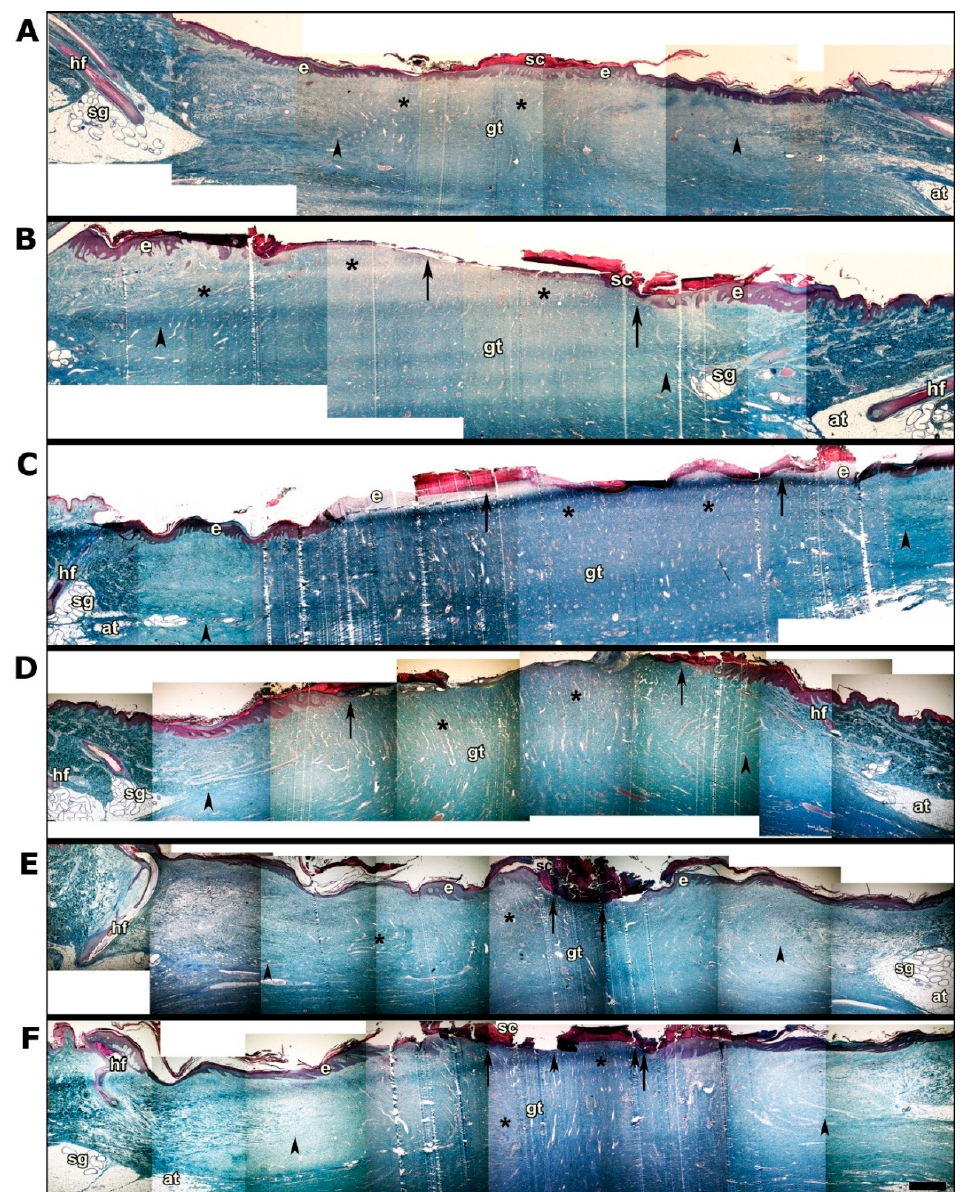
Figure 4. Histological study after 4 weeks of wound dressing implantation. Panoramic view showing the entire scar area. ( A , C , E ) correspond to the SGB biopsies of animals 1, 2 and 3, respectively. ( B , D , F ) correspond to the control (commercial wound dressing) biopsies of animals 1, 2 and 3, respectively. Hair follicles (hf), sweat glands (sg), granular tissue (gt) are shown. The arrowheads indicate the extent of granular tissue. The arrows indicate the extent of the healing surface. Asterisks indicate areas with high blood capillary and sinusoid content. Bar 1 mm.